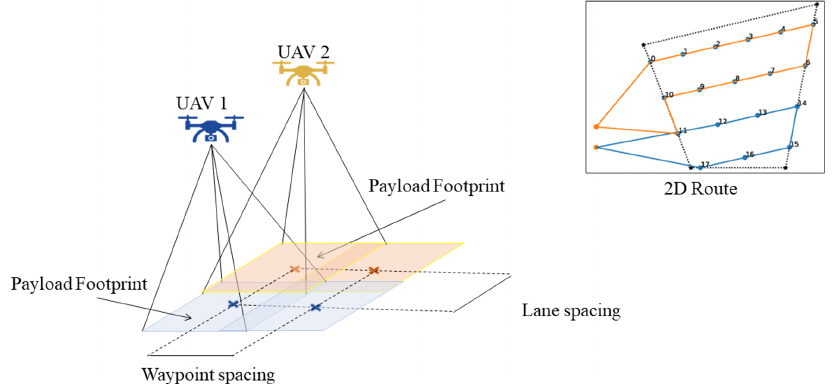
Figure 4. Footprint schema in 2D routing mission.